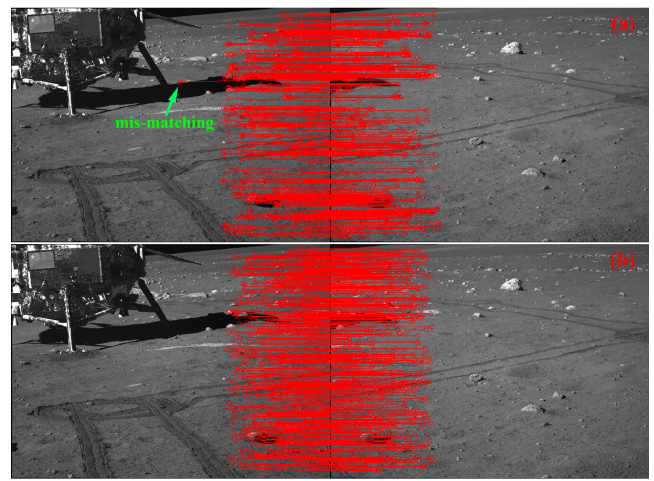
Figure 5. Schematic of feature matching when thr = 0.4. ( a ) a,b using SIFT (Scale Invariant Feature Transform) algorithm; ( b ) a,b using SURF (Speed-Up Robust Features)algorithm.